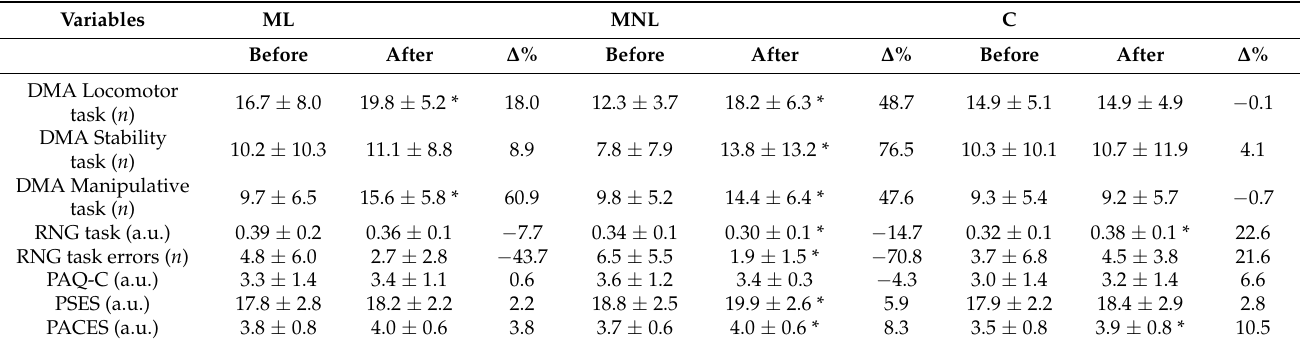
Table 1. Within-group, before–after comparisons of teaching approach effects on critical thinking, executive functioning, physical activity, self-efficacy, and